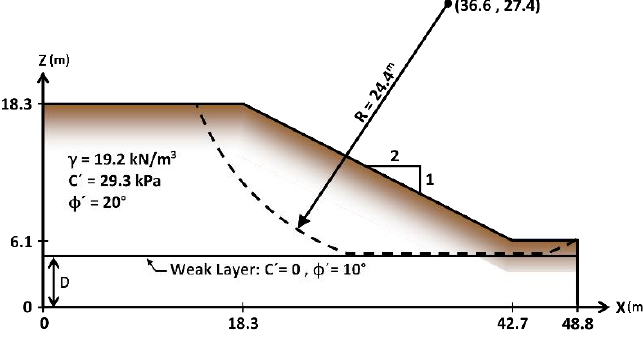
Figure 14. Homogeneous slope with a weak layer, studied by Fredlund and Krahn [97]. Table 8. Reported safety factors for the homogeneous slope with a weak layer (case 2).